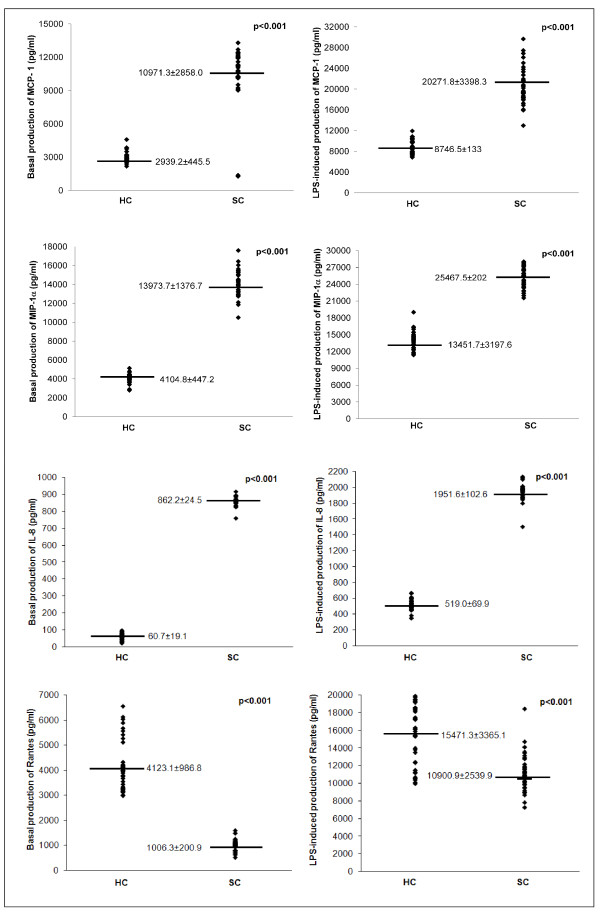
Comparison of chemokine production between SC patients and healthy controls. MCP-1, MIP-1α, IL-8 and RANTES release by non-stimulated and LPS-stimulated PBMC (pg/ml/106 cells) from 40 healthy controls (HC) and 51 schizophrenic (SC) patients. Supernatants were collected, stored at -80°C until analysis than measured for MCP-1, MIP-1α, IL-8 and IL-18 concentration using a commercial enzyme-linked immunosorbent assay (ELISA). All samples for a given assay were analyzed in duplicate at the same time. The ELISA values (in duplicates for each sample) have an error range lower than 10%. The variation coefficient of both inter-assay and intra-assay was <5%. Each data point represents the release of MCP-1, MIP-1α, IL-8 and RANTES from each patient. Horizontal bars indicate group mean values.